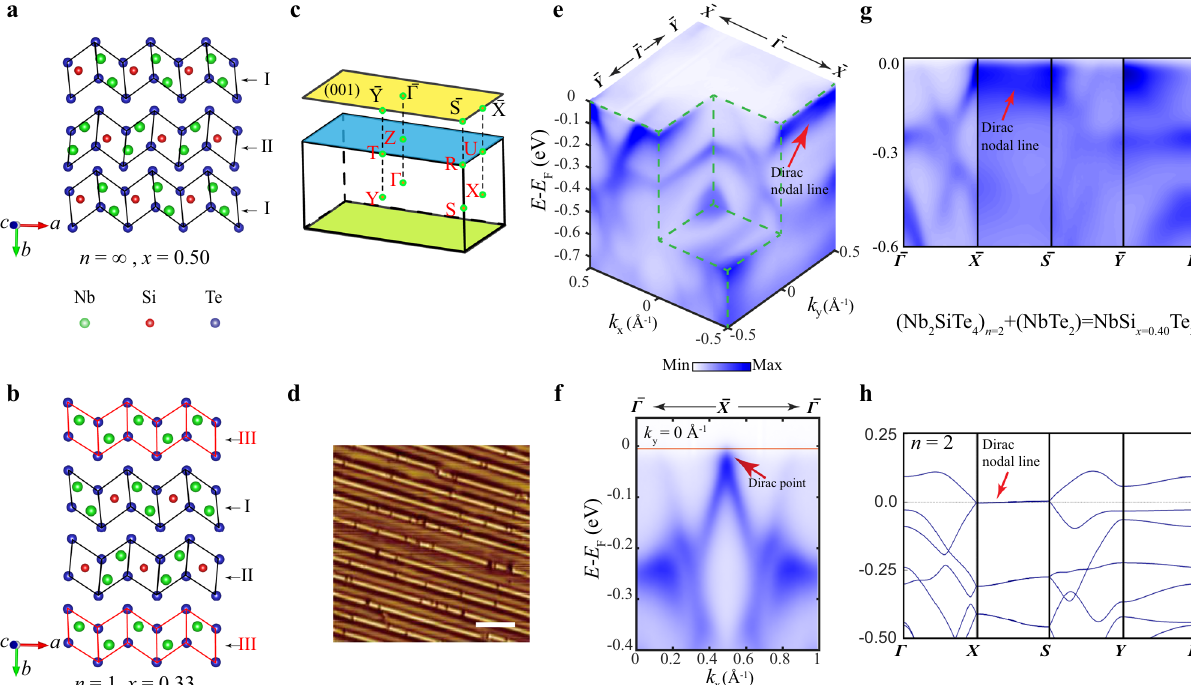
Fig. 1 Crystal structure and characterizations of NbSi x Te 2 . a Crystal structure of Nb 2 SiTe 4 ( n = ∞ , x = 0.5). Type I and II are two kinds of chains along the a -axis as building blocks. b Crystal structure of Nb 3 SiTe 6 ( n = 1, x = 0.33). Type I, II and III are three kinds of chains as building blocks. c The Brillouin zone (BZ) and its projection to the (001) surface of Nb 3 SiTe 6 . d STM topography image of NbSi x Te 2 . The bright lines show the metallic NbTe 2 chain (type III). Scale bar represents 10 nm. e 3D volume plot of the overall band structure of x = 0.40 ( n = 2) sample with Dirac nodal line labeled. f The photoemission spectrum along the high symmetry Γ (cid:1) X (cid:1) Γ directions of x = 0.40 ( n = 2) sample. Dirac point (DP) is labeled on the spectrum. g The photoemission spectrum along the high symmetry Γ (cid:1) X (cid:1) S (cid:1) Y (cid:1) Γ direction of x = 0.40 ( n = 2) sample. Dirac nodal line is labeled. h The ab-initio calculated band structure of x = 0.40 ( n = 2) sample from ref. 63. Dirac nodal line is labeled. Data in Fig. 1e – g were collected at h ν = 56 eV with sample temperature 20 K. For STM topography measurement, the bias voltage is 0.7 V, and the tunneling current is 50 pA. The sample temperature is 4.2 K. Data from ref. 58 (Reprinted (adapted) with permission from ref. 58 . Copyright (2022) American Chemical